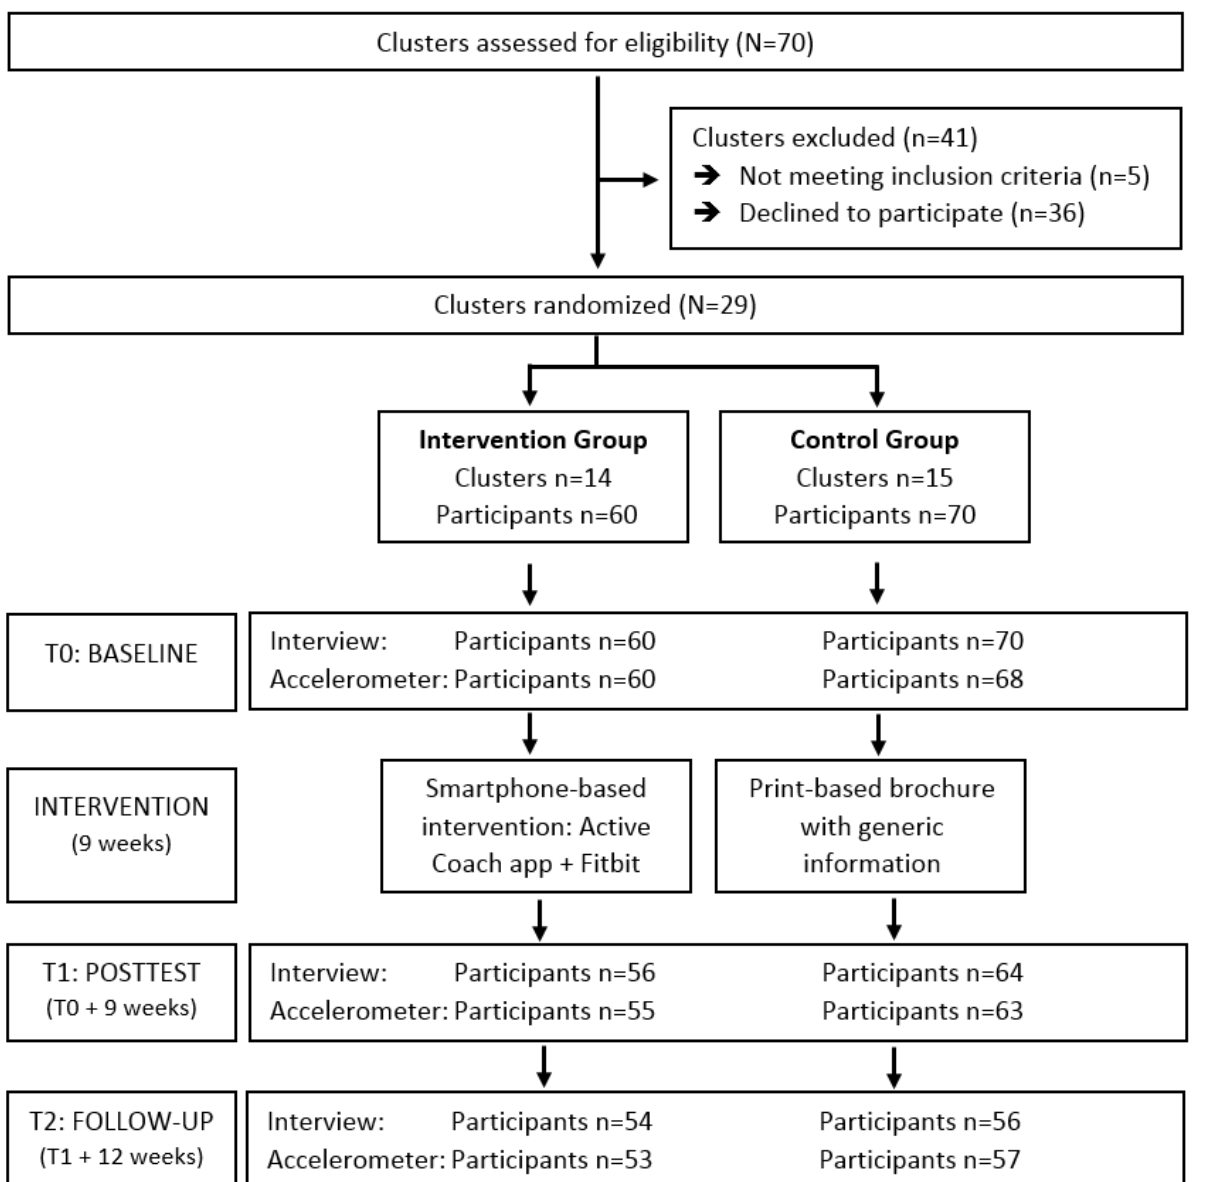
Figure 1. Flowchart of the smartphone-based